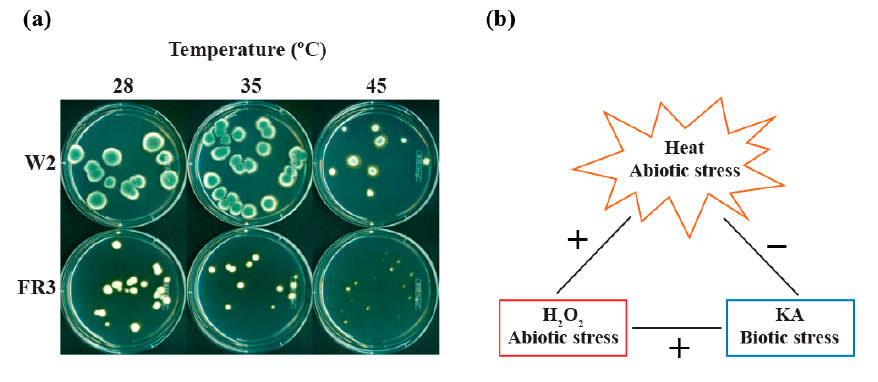
Figure 4. ( a ) Reduced growth of P. expansum FR3, a fludioxonil-resistant mutant, comparing to W2, a parental strain; ( b ) Diagram showing the interaction characteristics between heat, KA and H 2 O 2 . +: positive interaction ( i.e ., enhancement of antifungal activities when combined), − : no interaction ( i.e ., no enhancement of antifungal activities when